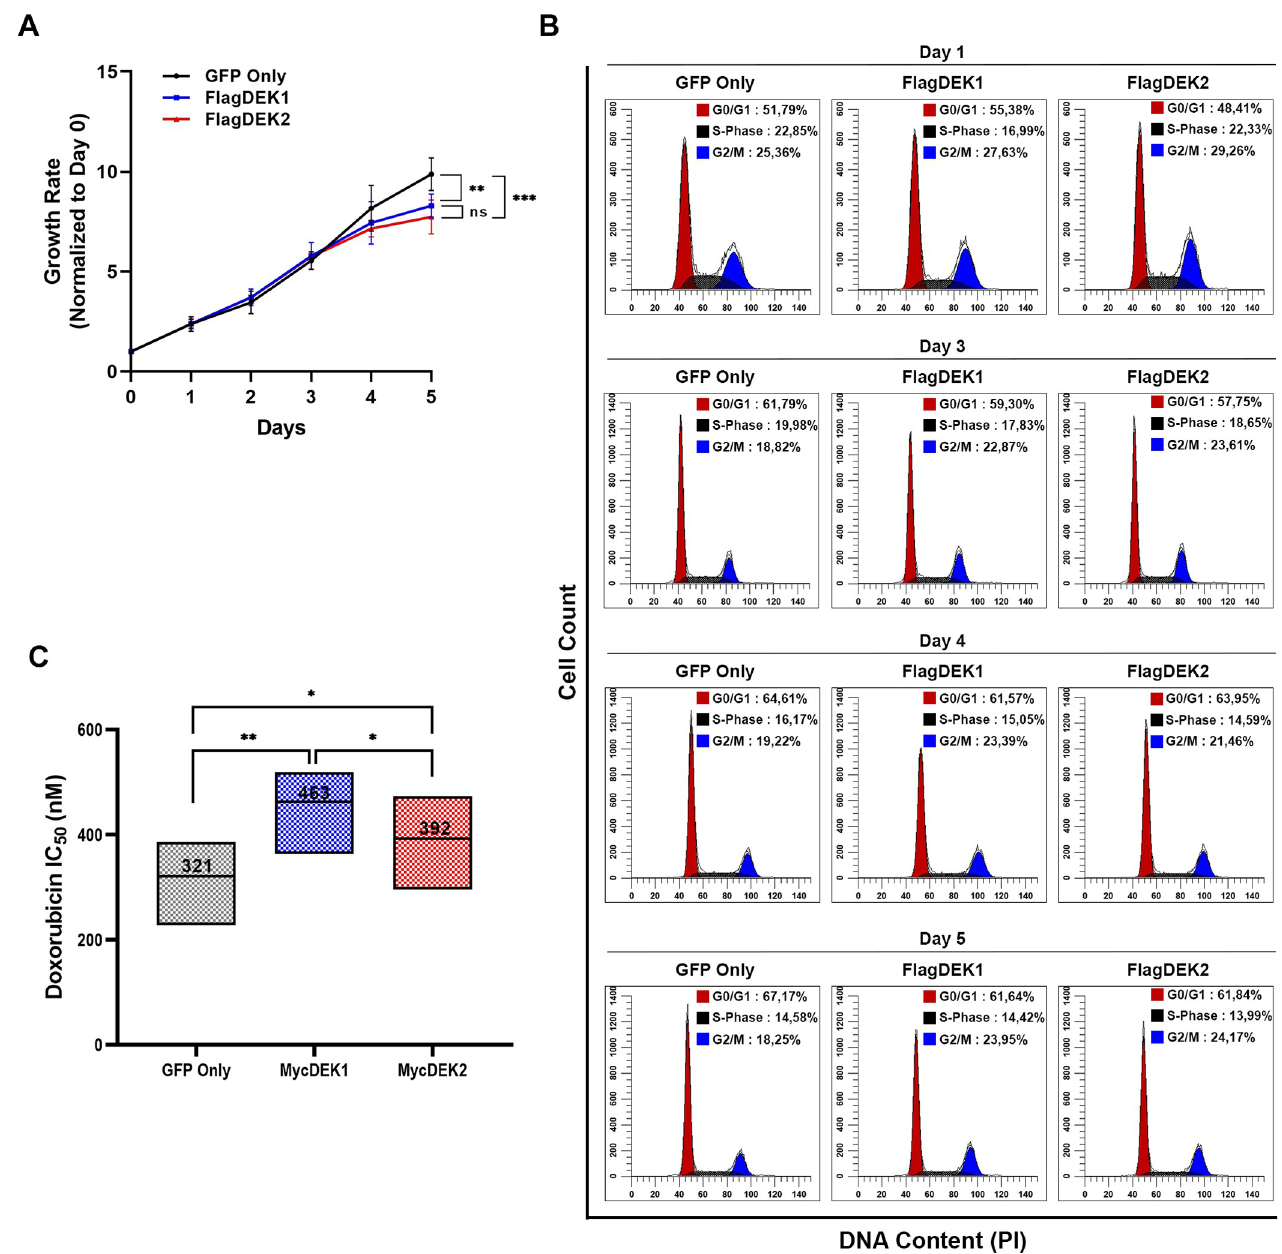
Fig 3. Stable overexpression of DEK isoforms slows the proliferation and affects the response to doxorubicin. (A) The growth curve of HS-27A cells stably expressing the FlagDEK1 or FlagDEK2 was generated by following the cell proliferation for 5 consecutive days using WST-1 assay. Cells transduced with an empty vector (GFP-only) were used as a control. The growth rate on each day was calculated by dividing each day’s absorbance by the absorbance of Day-0. The graphic shows mean values ( ± SEM) obtained from three independent experiments, each performed as triplicates (Two-way ANOVA Tukey’s multiple comparisons test: �� P = 0.005; ��� P < 0.001, ns: not significant). (B) Parallel to growth curve analysis, the cell cycle was also analyzed using the same cells on days 1, 3, 4, and 5. Graphics reveal the percentage of cells at each stage of the cycle on the corresponding days. (C) Doxorubicin dose-response (IC50 values) of HS-27A-MycDEK1 or MycDEK2 cells were analyzed by using WST-1 assay. The graphic indicates the mean of three independent experiments ( ± SD, Paired t- test: � P = 0.0420 (MycDEK1 vs. MycDEK2); P = 0.0132 (GFP-Only vs. MycDEK2), �� P = 0.0027).